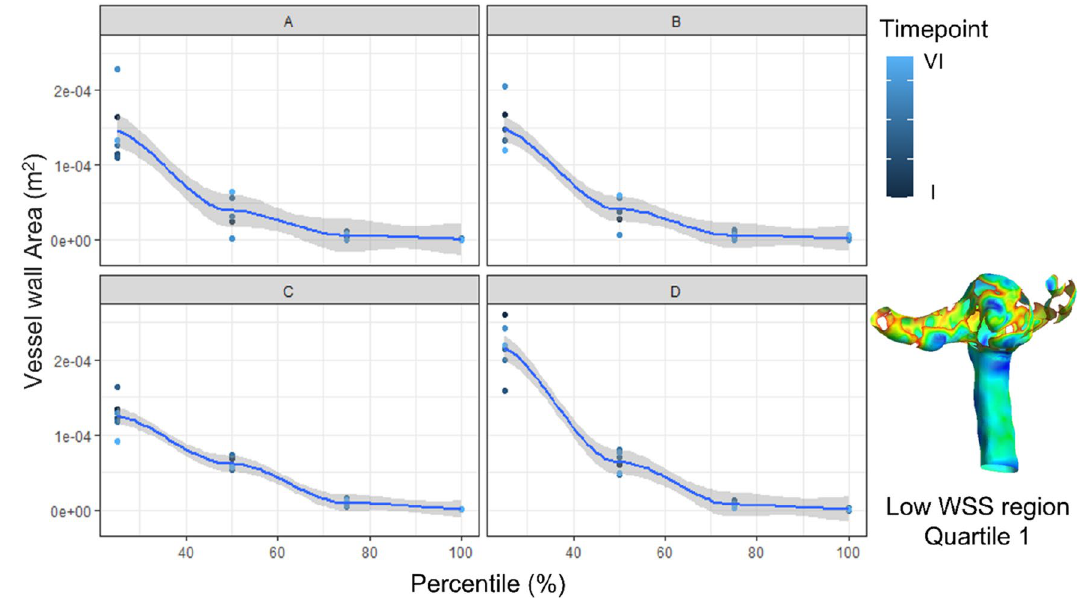
Figure 6. Difference in WSS area for geometries reconstructed by different operators at different timepoints. The contour represents an example of the first quartile of WSS.